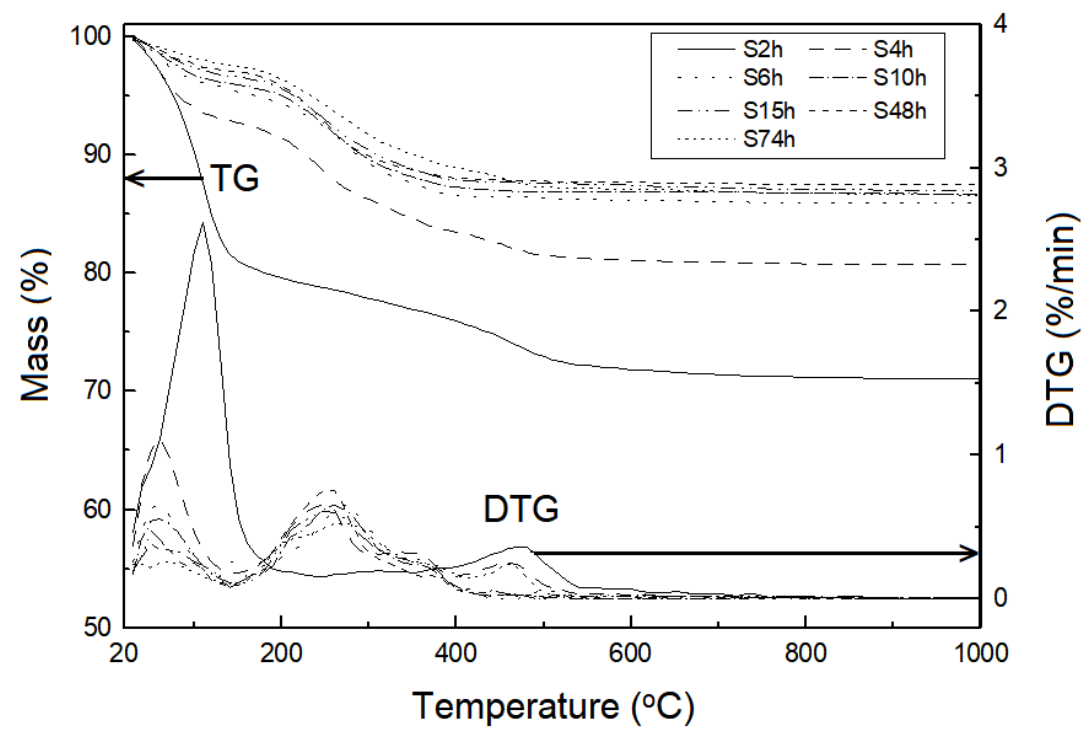
Figure 5. TG and DTG curves of the solids obtained during the crystallization of AlPO 4 -11, at different synthesis times.